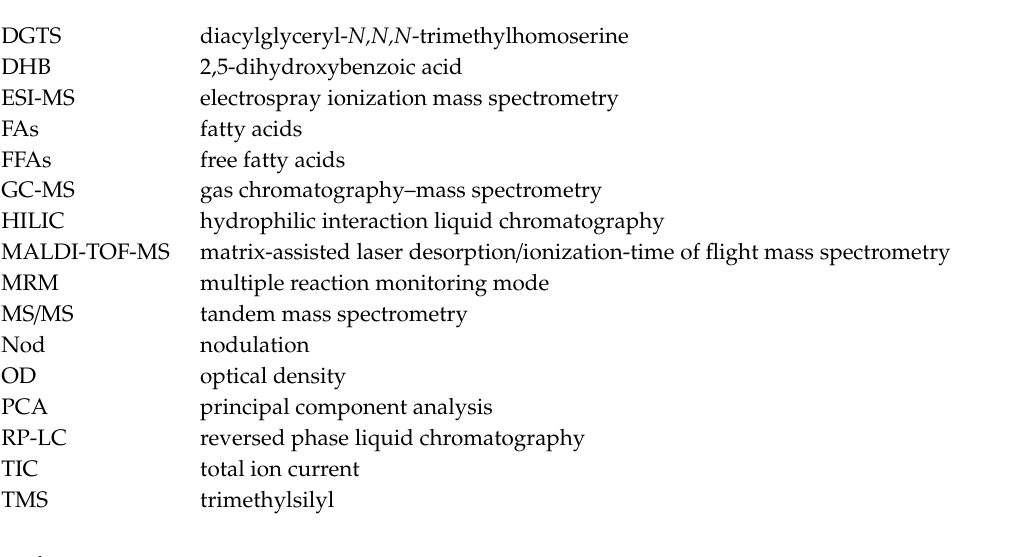
application, Table S1-7: List of background signals, observed in mass spectra of blanks, Figure S1-7: Tandem mass spectrum of m / z 416.97, corresponding to DHB related signal, Table S1-8: Result table, compatible with the input requirements of the MetaboAnalyst software tool, all the replicates using normalization by peak heights of the signals related to stearic acid ( m / z 421.17), Table S1-9: Result table, compatible with the input requirements of the MetaboAnalyst software tool, for only average peak heights within each technical replicate using normalization